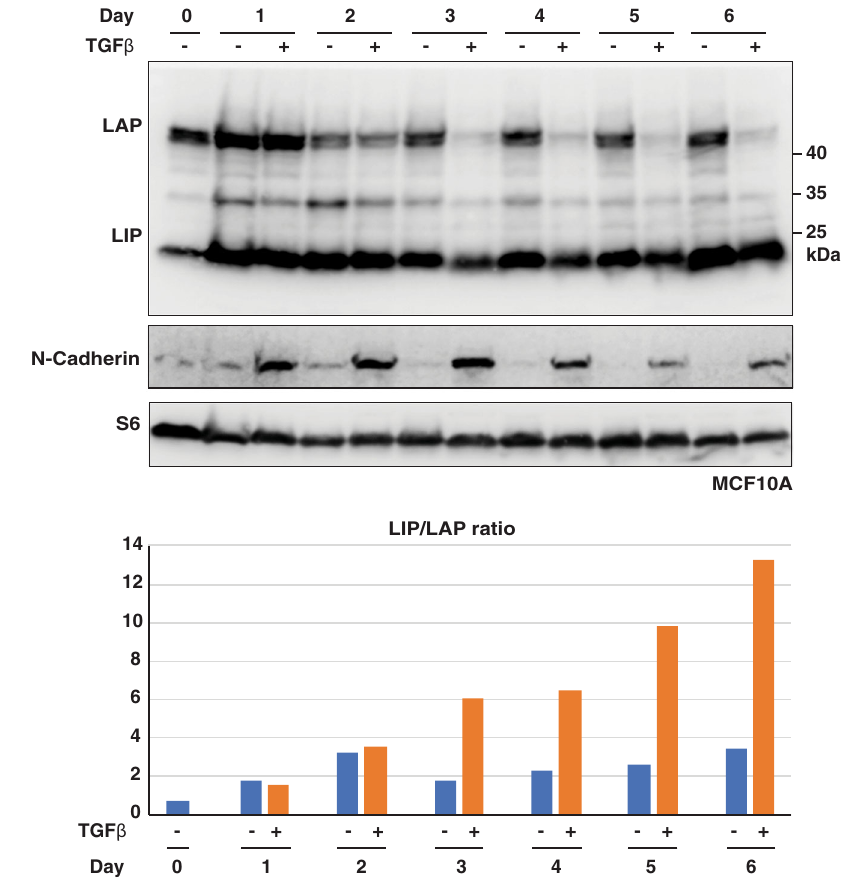
Fig. 8 Treatment with TGF β induces high LIP/LAP expression ratios. The upper immunoblot shows expression of LIP and LAP, the blot below the induction of the EMT marker N-cadherin. The lower blot shows expression of the ribosomal protein S6 for loading control. The bar graph show quanti fi cations of relative LIP/LAP expression